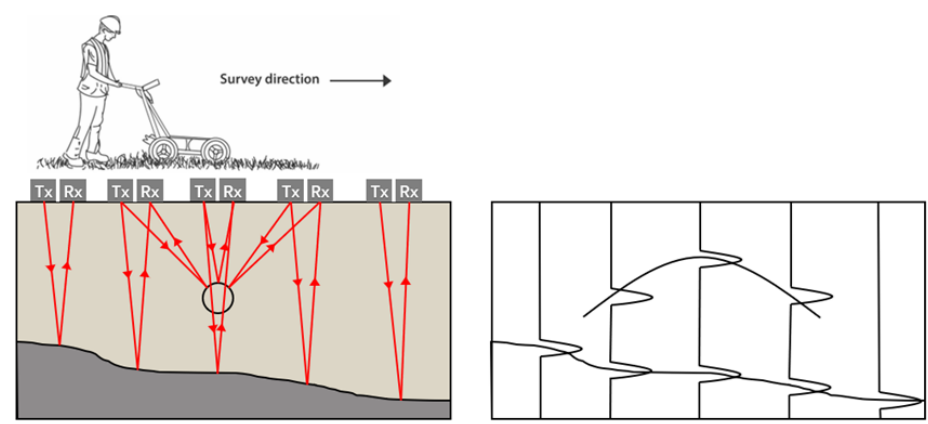
Figure 1. Basic principle of